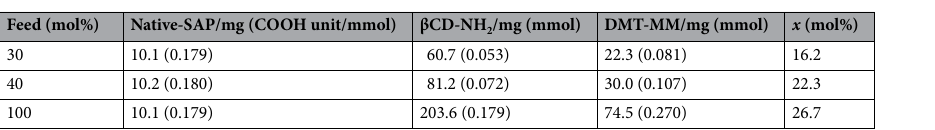
Table 1. Conditions and results of preparation of βCD( x )-SAP